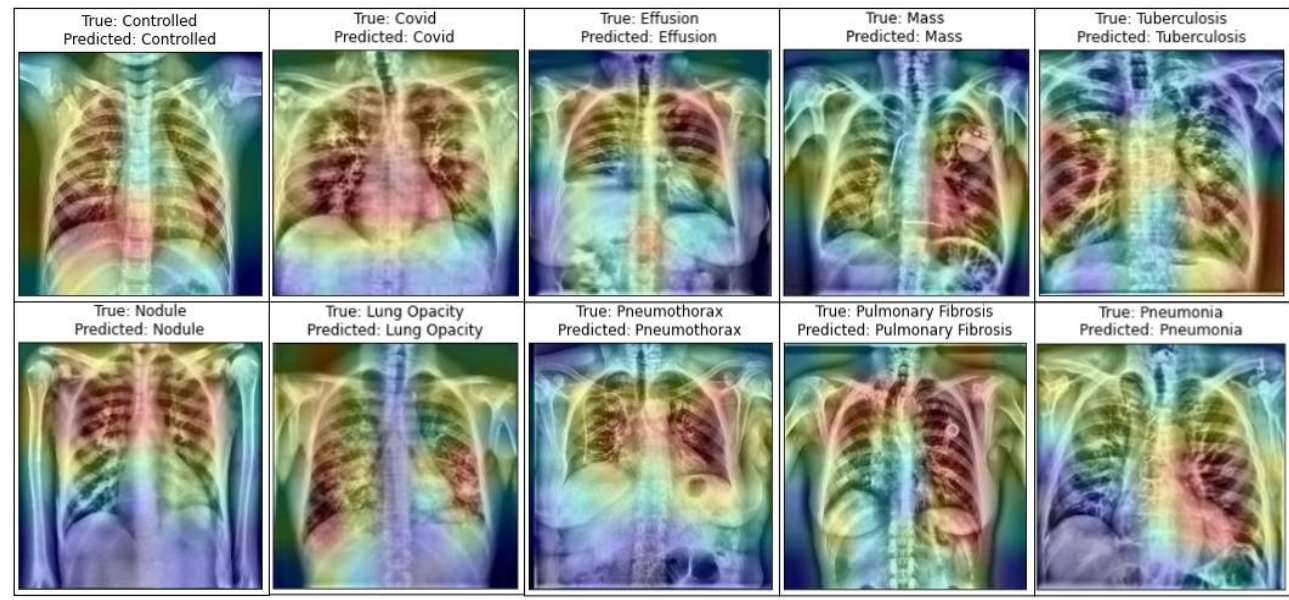
Figure 14. Representation of infected area of lung in X-ray images utilizing Grad-CAM on the LungNet22 model.